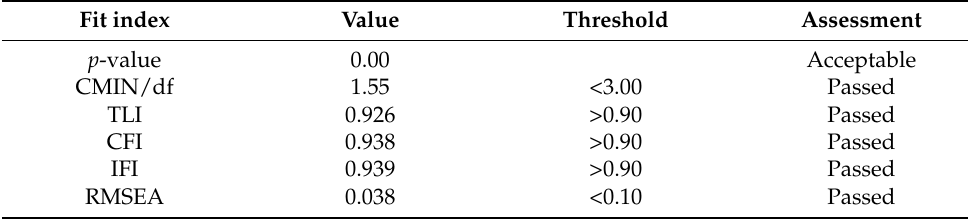
Table 11. The goodness of fit of the multigroup structural model.